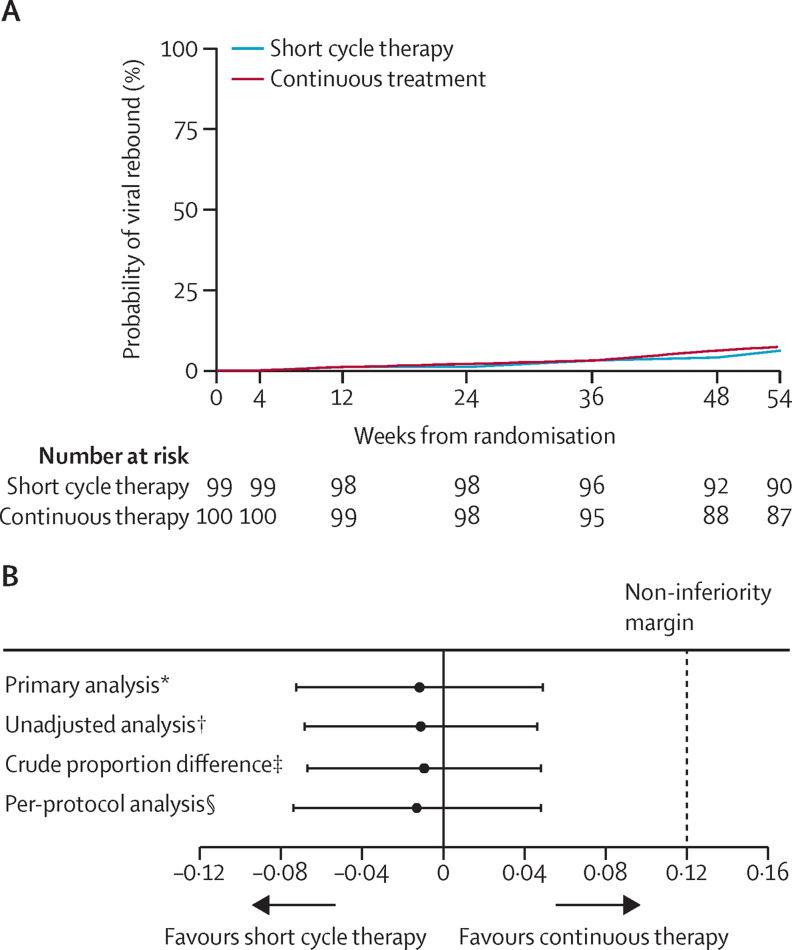
Time to viral rebound(A) Kaplan-Meier graph adjusted for stratification factors—time from randomisation to viral rebound (confirmed viral load ≥50 copies per mL). (B) Estimated difference in proportion of participants with viral rebound (two-sided 90% CI) between short cycle therapy and continuous therapy at week 48 for different analyses. *Difference in estimated probability of viral rebound, Kaplan-Meier methods, with adjustment for study stratification factors. †Difference in estimated probability of viral rebound, Kaplan-Meier methods. ‡With exact confidence intervals. §Kaplan-Meier methods, censoring individuals who violated the profile at that time, with adjustment for study stratification factors.